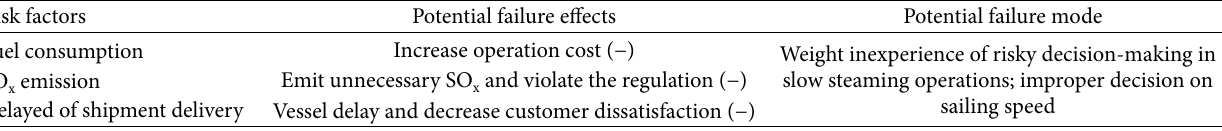
Table 2: Gains or losses generated by main risk factors of slow